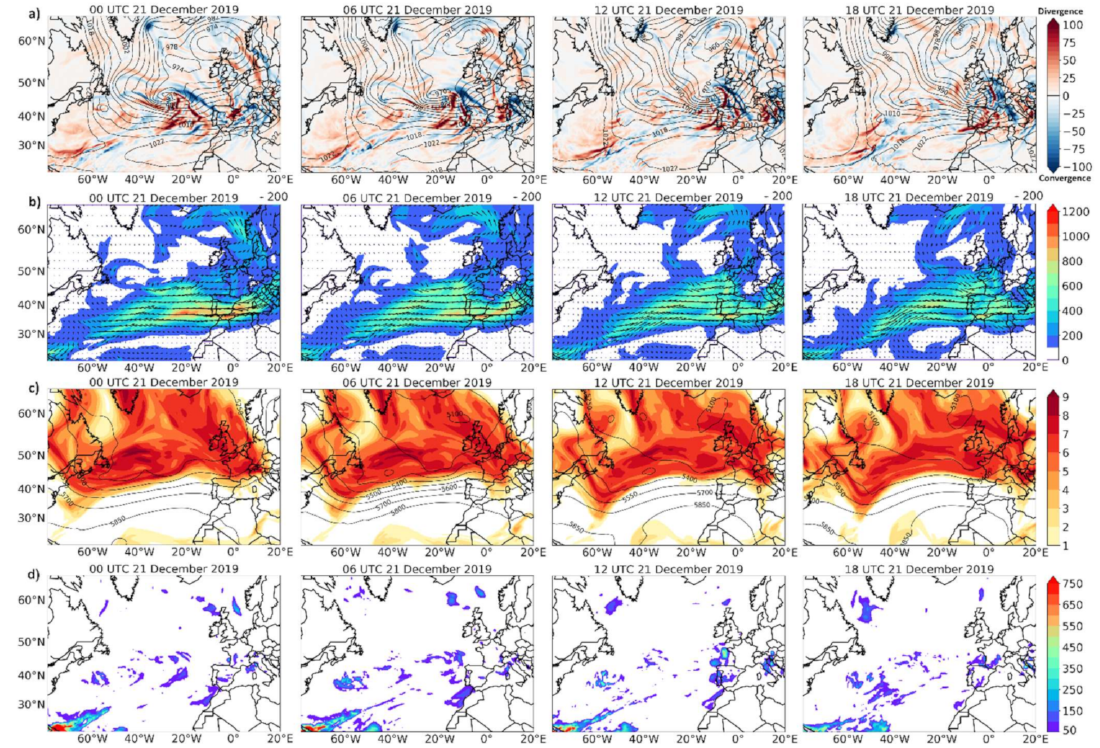
Figure 4. As Figure 2; Figure 3 but for the storm Fabien on 21 December 2019. The configuration of the MSLP and the geopotential at 500 hPa patterns on December 16 at 00 UTC (Figure 2a,c) reveals a deep trough observed from the surface to upper levels to the west and near of mainland Portugal, which is also visible at higher levels by the intense PV that is mainly observed to the southwest of mainland Portugal (Figure